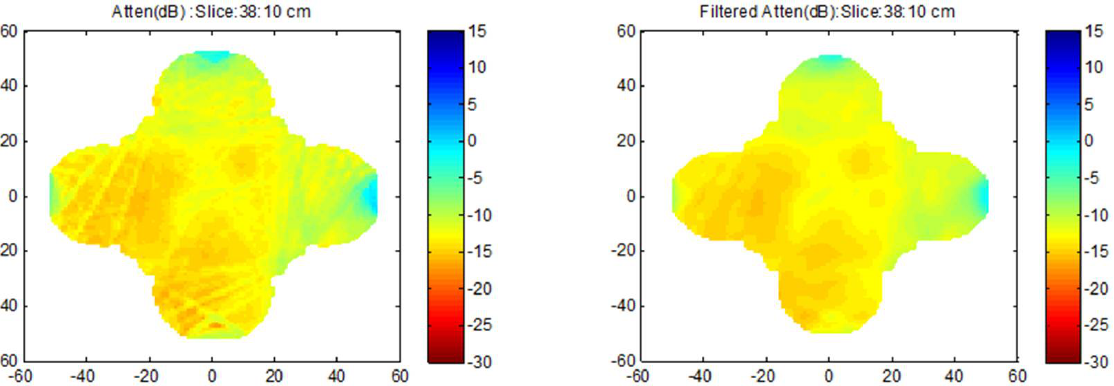
Figure 18. Tomographic reconstruction images before and after smoothing the result obtained considering the attenuation.